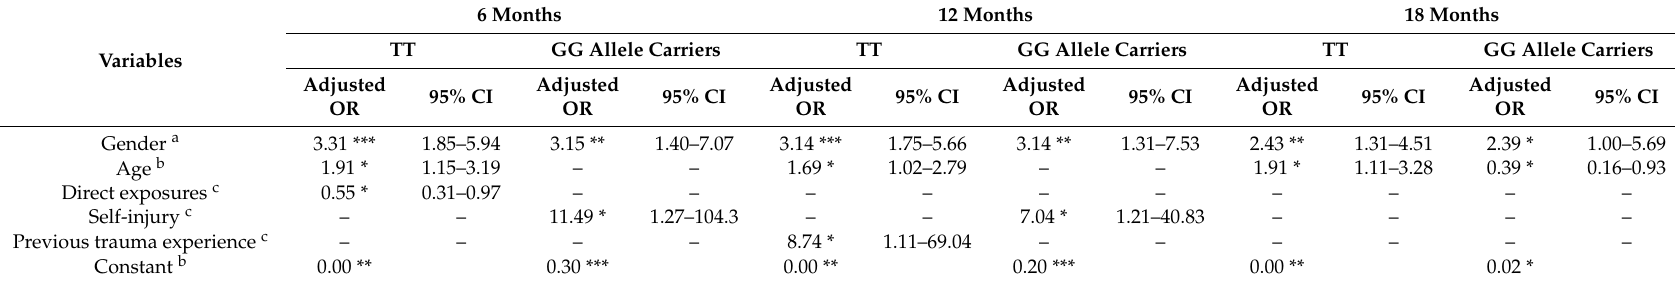
Table 4. Potential factors associated with depression prevalence in the subjects with different genotypes of TNFRII rs1061622 at 6, 12, and 18 months after the